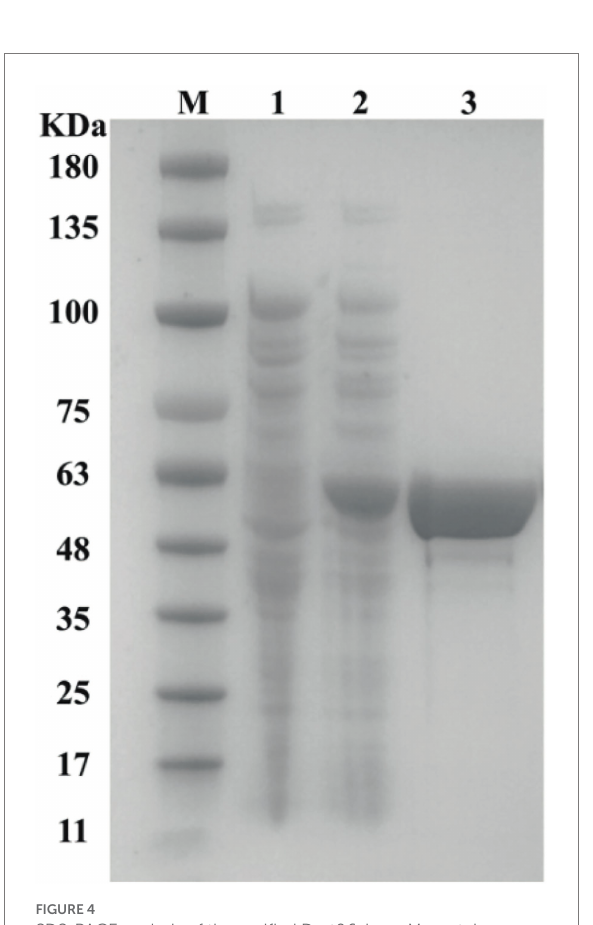
FIGURE 4 SDS-PAGE analysis of the purified Dmt06. Lane M: protein molecular marker; lane 1: crude extract of E. coli BL21 harboring pET29a; lane 2: crude extract of E. coli BL21 harboring pET- dmt06 ; lane 3: purified